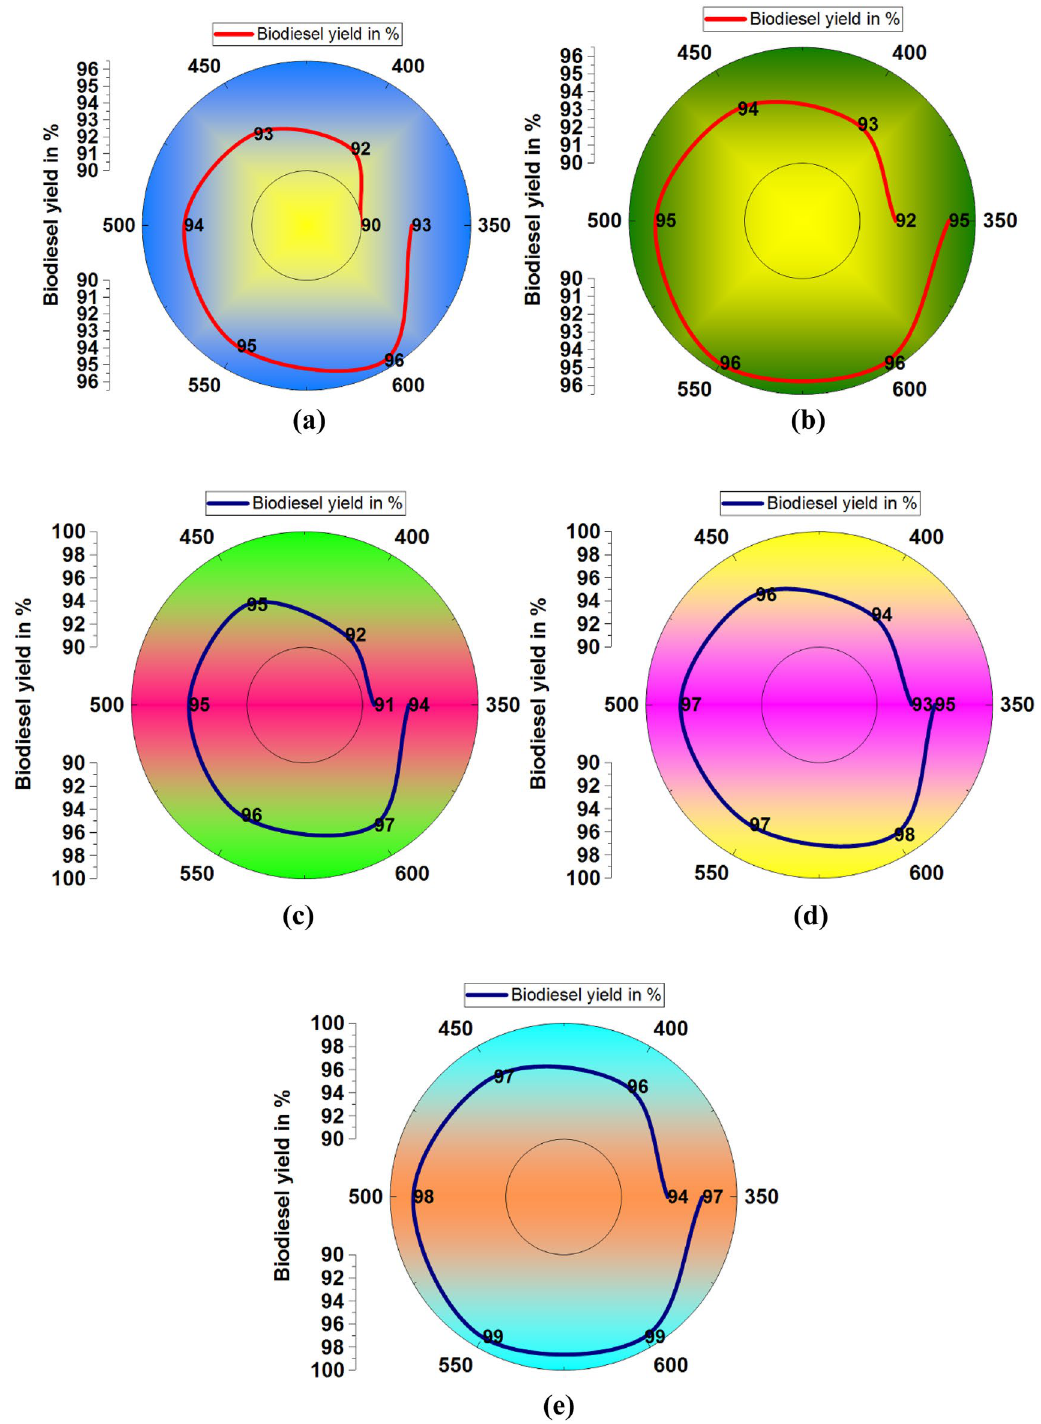
Figure 10. Mixing speed (rpm) vs. biodiesel yield in % using of plant waste: ( a ) Bagasse ( b ) Papaya stem ( c ) Banana peduncle ( d ) Moringa oleifera ( e ) Mixed